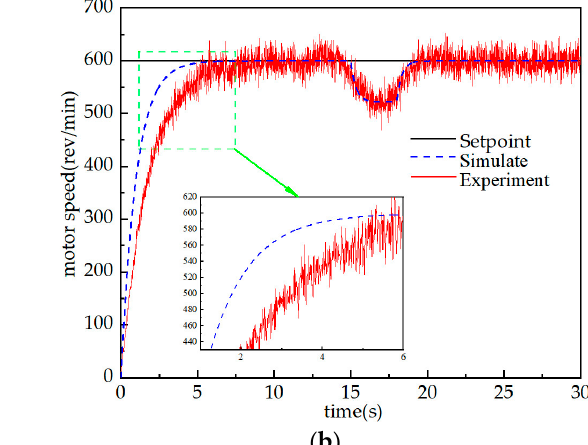
Figure 13. The ITAE box plot. Figure 14. The Bode diagram of the PMSS. 6. Conclusions The PMSS is frequently implemented for the precise speed control of mechanical equipment and industrial processes. This research suggests a brand-new technique for the PMSSs speed control that applies a PID controller based on the GWOPSO algorithm to